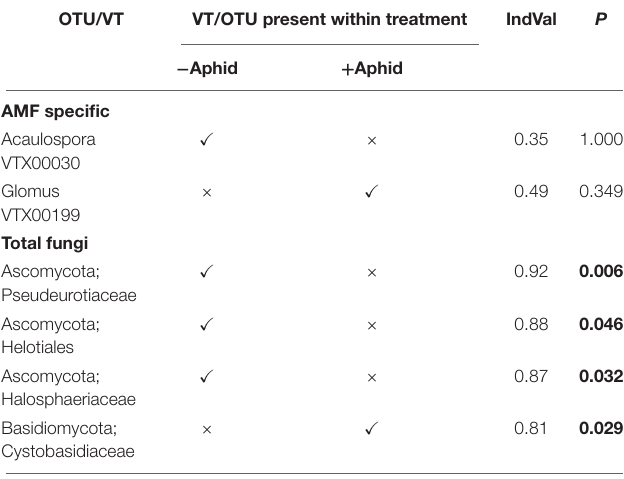
TABLE 6 | Indicator species analysis of AMF specific amplicon VTs and total fungi amplicon OTUs as indicators of untreated or aphid treated barley